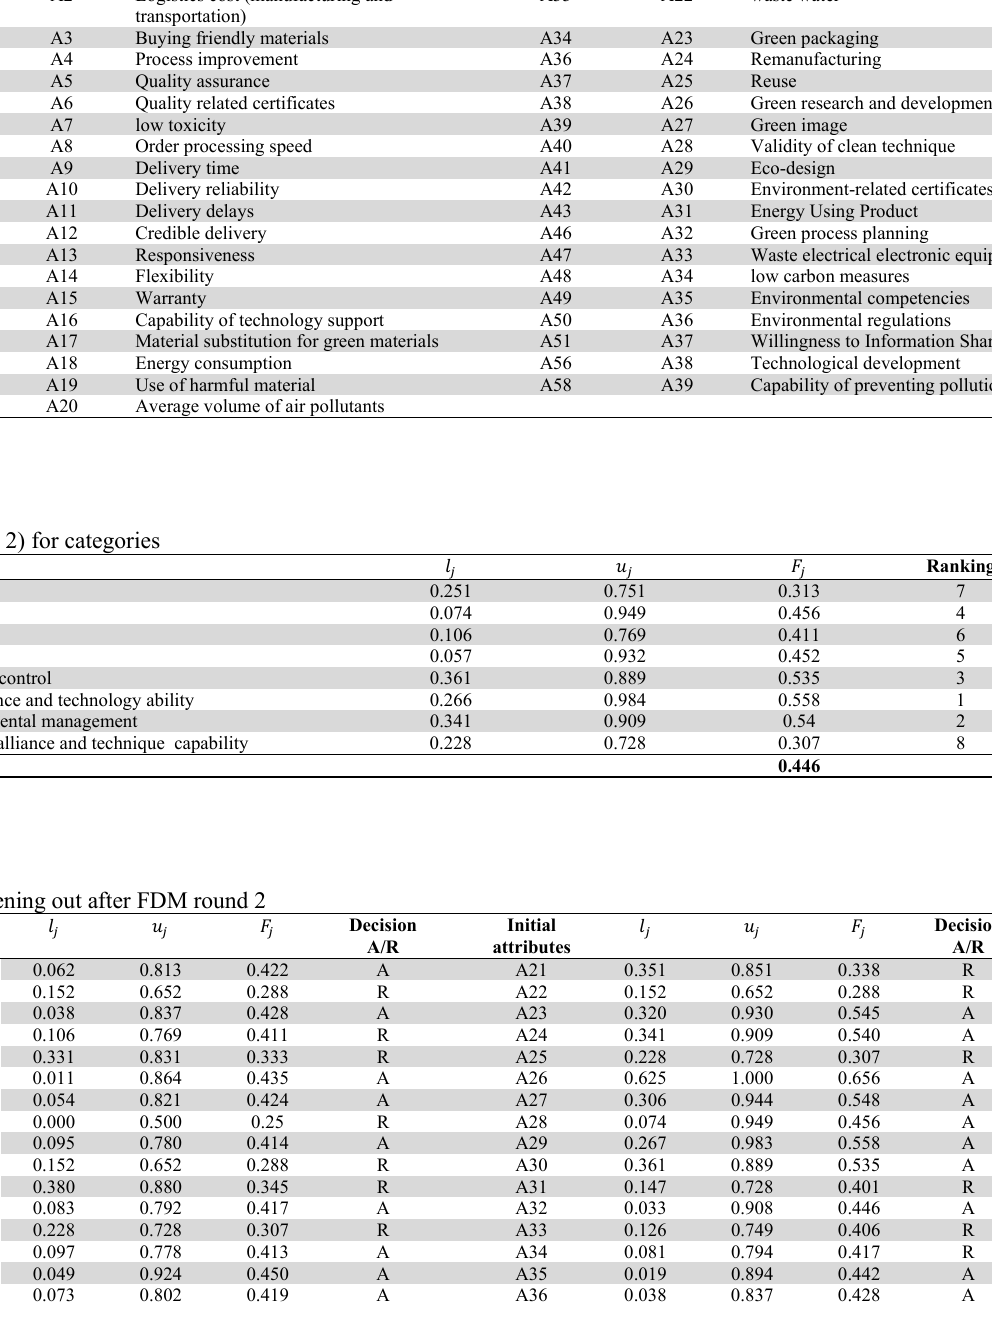
Results after FDM round 1 Initial attributes